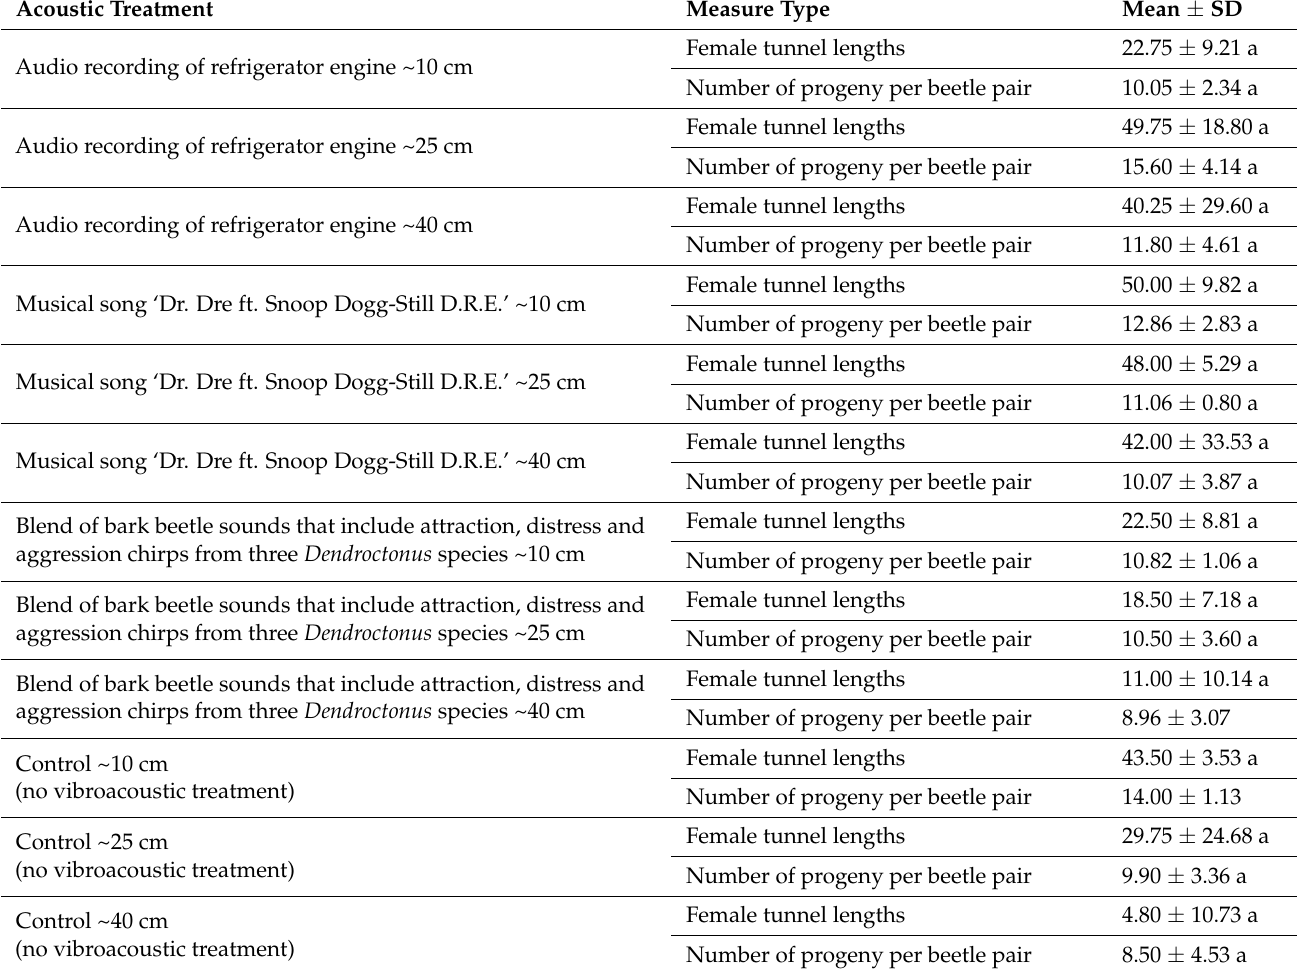
Table A2. Post hoc statistical analysis (Tukey HSD test) of measured variables (Mean ± SD) between acoustic treatments. Letter “a” represents a statistically not significant difference between acoustic treatment groups or lengths on the log (female tunnel lengths: Welch’s ANOVA–F 11, 15.18 = 1.42, p = 0.208; number of progeny per beetle pair: Kruskal–Wallis ANOVA: H = 23.80, d.f. = 11, p = 0.016